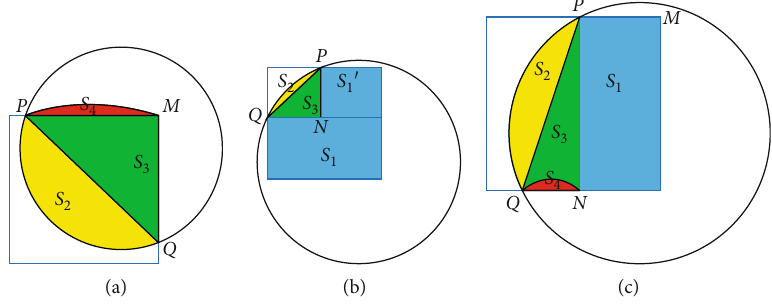
Figure 4: Two typical cases of a spherical disk intersecting a